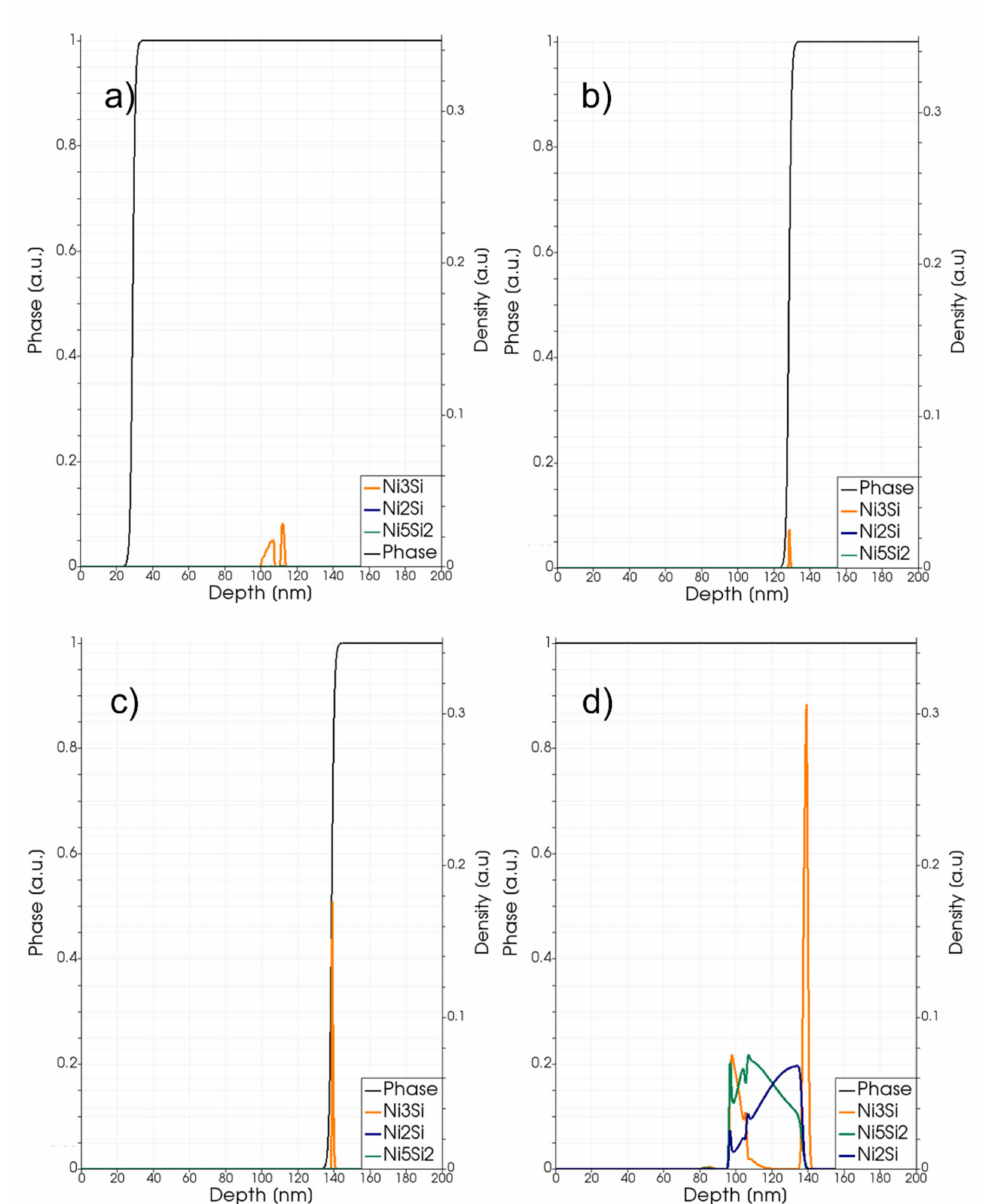
Figure 8. Phase-field (black line and left axis) and simulated local density (right axis scale) of the Ni 3 Si (dark yellow lines), Ni 5 Si 2 class (dark green lines) and Ni 2 Si (blue lines) for a laser annealing process with fluence E dens = 3.2 J/cm 2 . Snapshots ( a – d ) are taken at t = 120, 160, 200, 350